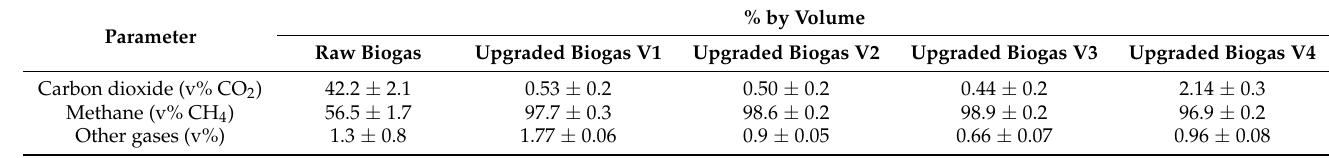
Figure 4. Correlation analysis of the effects of biogas flow rate on ( a ) breakthrough time; ( b ) sorption capacity; ( c ) mass of carbon dioxide removed. Table 4. Upgraded biogas characteristics in comparison with raw biogas (as